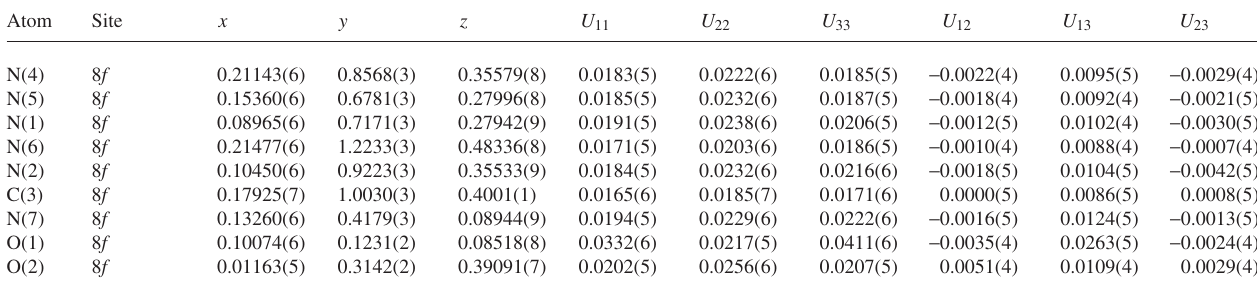
Table 3. Atomic coordinates and displacement parameters (in Å 2 ) .